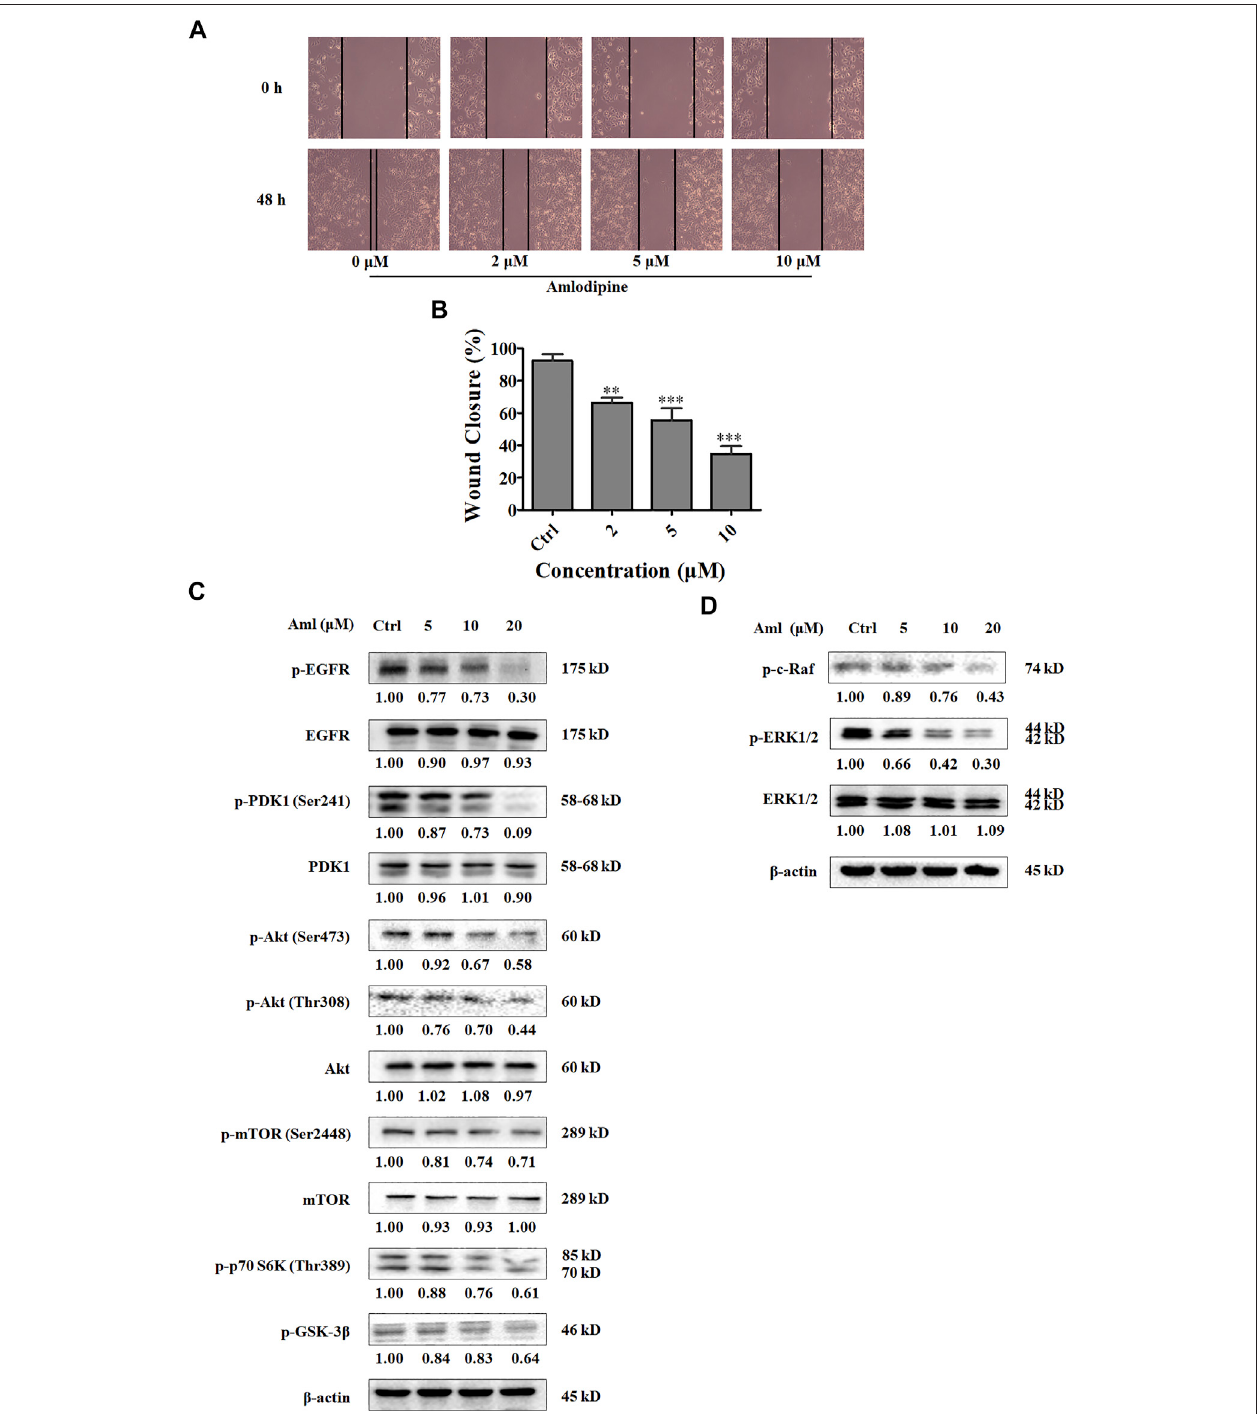
FIGURE 2| Amlodipine suppresses A549 cells migration and PI3K/Akt and Raf/ERK MAPK pathways. (A) The effect ofamlodipine on cell migration wasdetected byperformingawound-healingassayat48 h. (B) Quanti fi cationofresultsin (A).(C) ThelevelsofAktpathwayproteinswereanalyzedbyWesternblottingaftertreatment with amlodipine. (D) The phosphorylation of Raf and phosphorylation and total ERK1/2 were analyzed by Western blotting after treatment with amlodipine. Data are presented as mean ± SD of three independent experiments. ** p < 0.01 and *** p < 0.001.